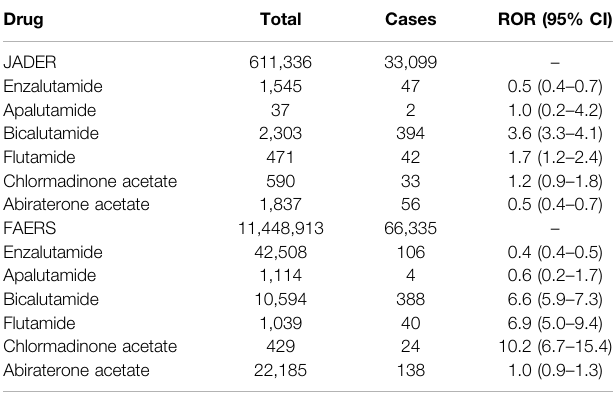
TABLE 3 | Number of reports and the reporting odds ratios by antiandrogen drugs.